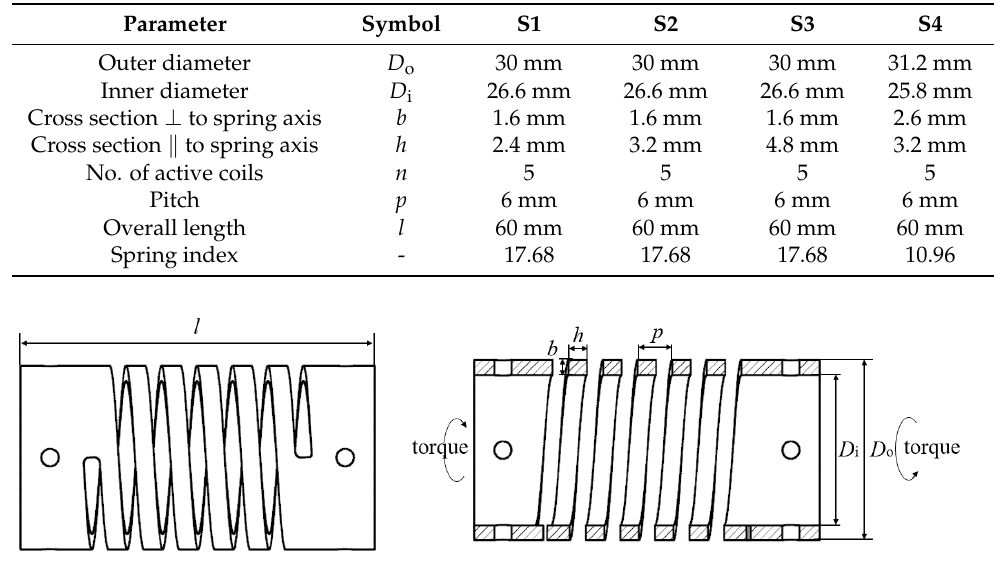
Figure 3. Schematics of the SMAMS. Table 2. Geometric parameters.